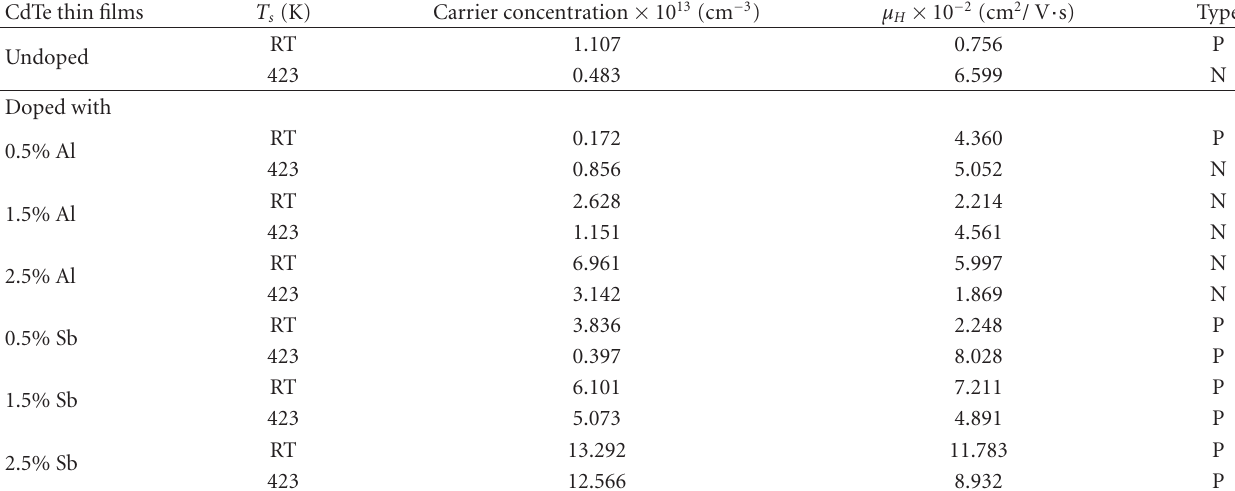
Table 2: Values of carrier concentration and μ H for undoped and doped CdTe thin films deposited at RT and 423